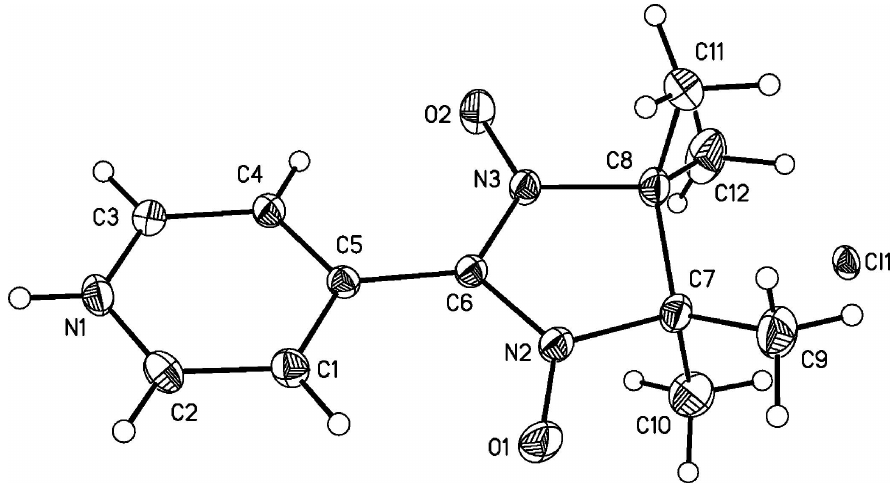
Figure 1 ORTEP drawing of the title compound with atom labeling. The thermal ellipsoids are drawn at 30% probability level. 4,4,5,5-Tetramethyl-2-(4-pyridinio)imidazoline-1-oxyl-3-oxide chloride Crystal